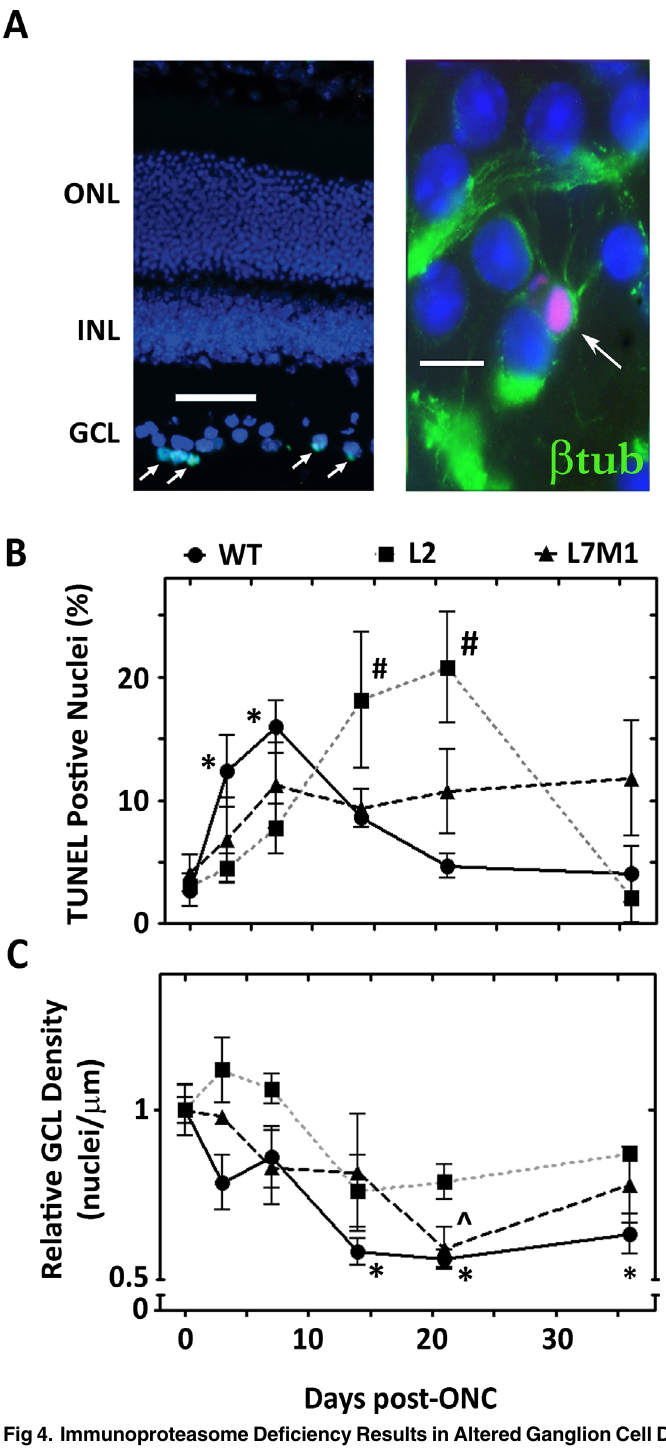
Fig 4. Immunoproteasome Deficiency Results in Altered Ganglion Cell Death after ONC. ( A, left ) Representative retinal section 11 days following ONC stained with DAPI (blue) and TUNEL (green). GCL, ganglion cell layer; INL, inner nuclear layer; ONL, outer nuclear layer. Image was taken with a 20x objective and the scale bar indicates 50 μ m. ( A, right ) Representative retinal whole mount stained with anti- β III-tubulin (green), TUNEL (red, arrow), and DAPI (blue). Image was taken with 100x objective and the scale bar indicates 10 μ m. (7 days following ONC) ( B ) Summary of the percent TUNEL-positive cells in the GCL following ONC from WT ( ● ), L2 ( ■ ), and L7M1 ( ▲ ) mice. Results are the mean ± S.E. of 3 – 9 mice/group compared to